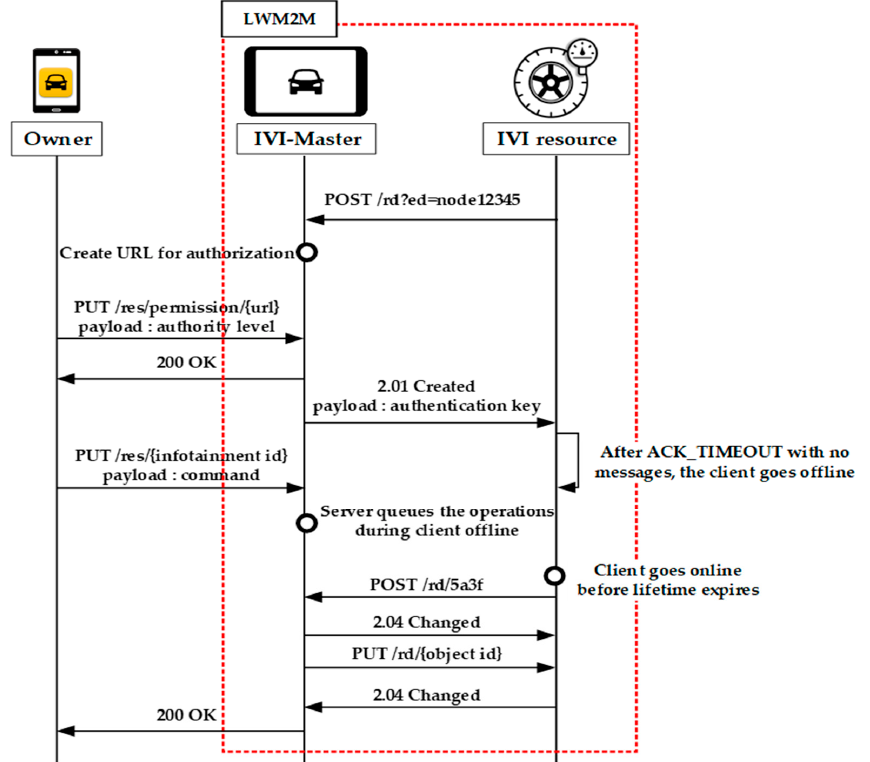
Figure 5. Use of LWM2M standard for IVI services.